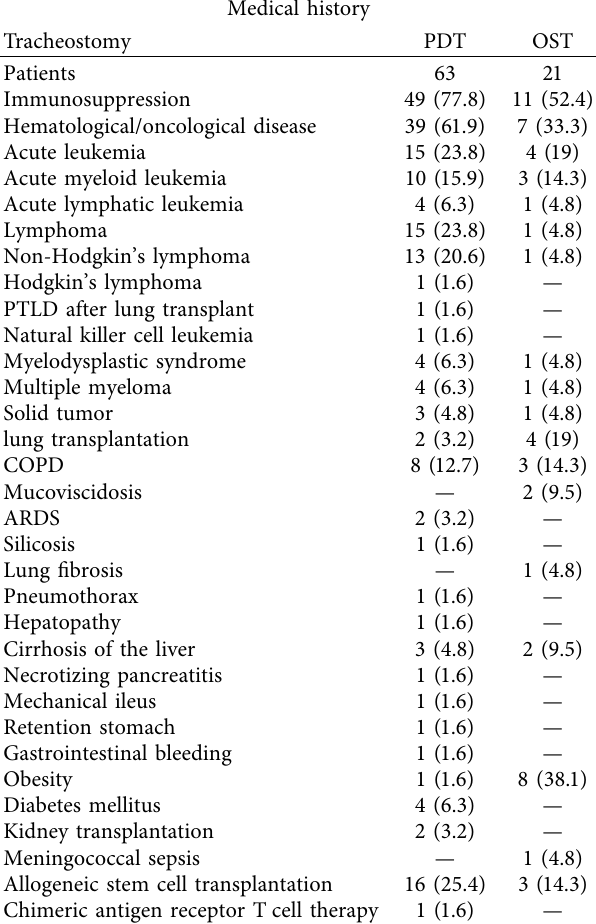
Table 2: Medical history of all patients; patients can be counted more than once due to